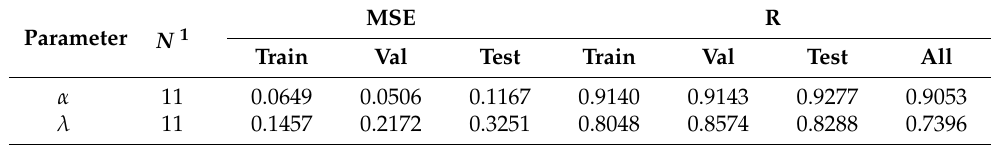
Table 3. Performance of the BPNN model for different parameters. Parameter